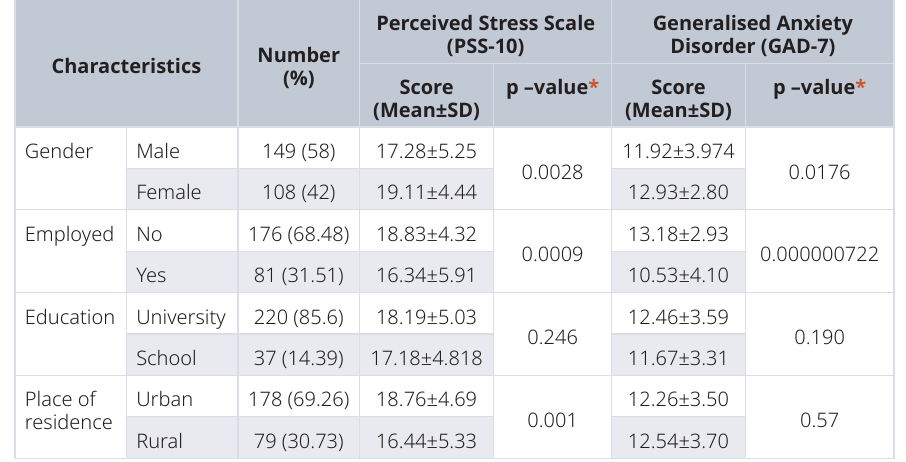
Table 1. Demographic characteristics of participants showing perceived stress score and generalized anxiety disorder scale score.